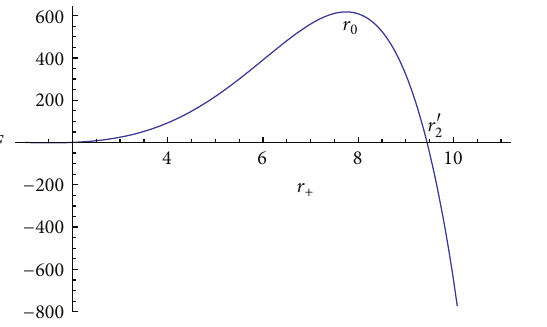
Figure 14: Plot of free energy ( F ) against horizon radius ( 𝑟 + ), for 𝛼 󸀠 = 1.0 , 𝑄 = 5 , and 𝑏 = 0.5